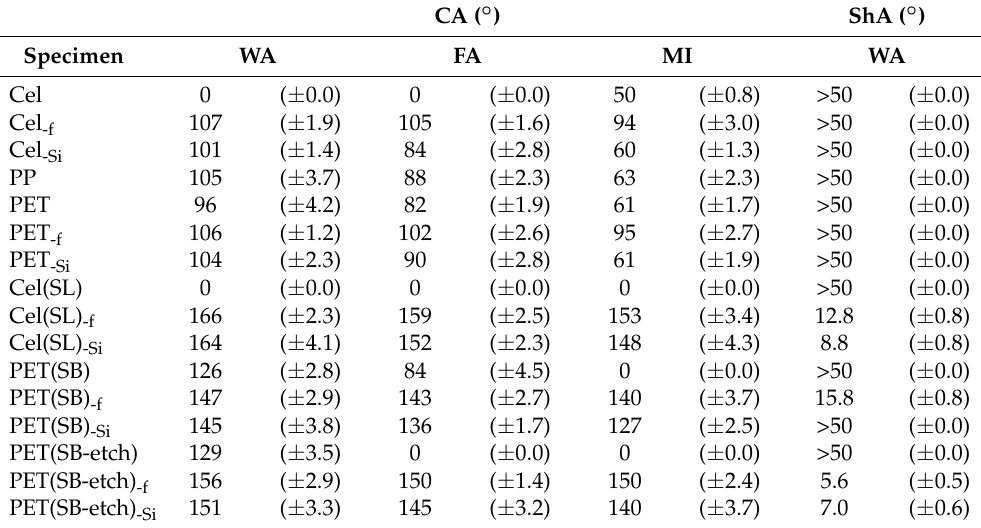
Figure 7. Surface roughness observed by atomic force microscopy (AFM). ( a ) Polyethylene terephthalate (PET) film; ( b ) PET spunbond fabric; ( c ) alkali-etched PET spunbond fabric. Table 6. Contact and shedding angles of